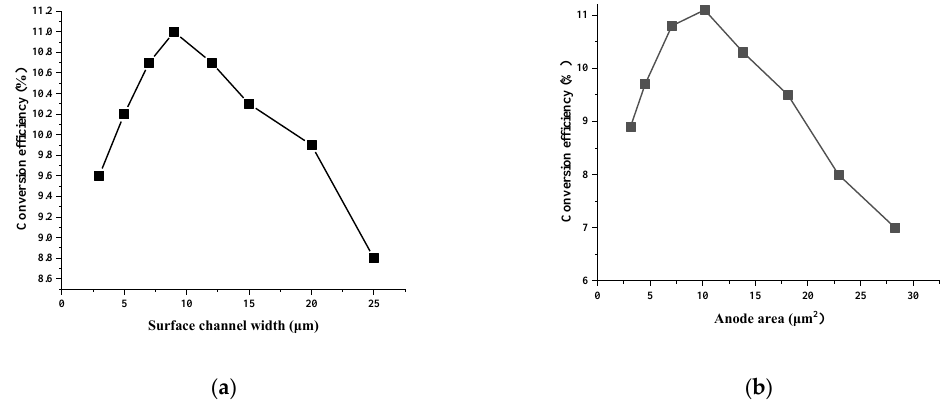
Figure 3. Simulated optimum conversion efficiency with ( a ) different surface channel widths and ( b ) different anode junction areas.